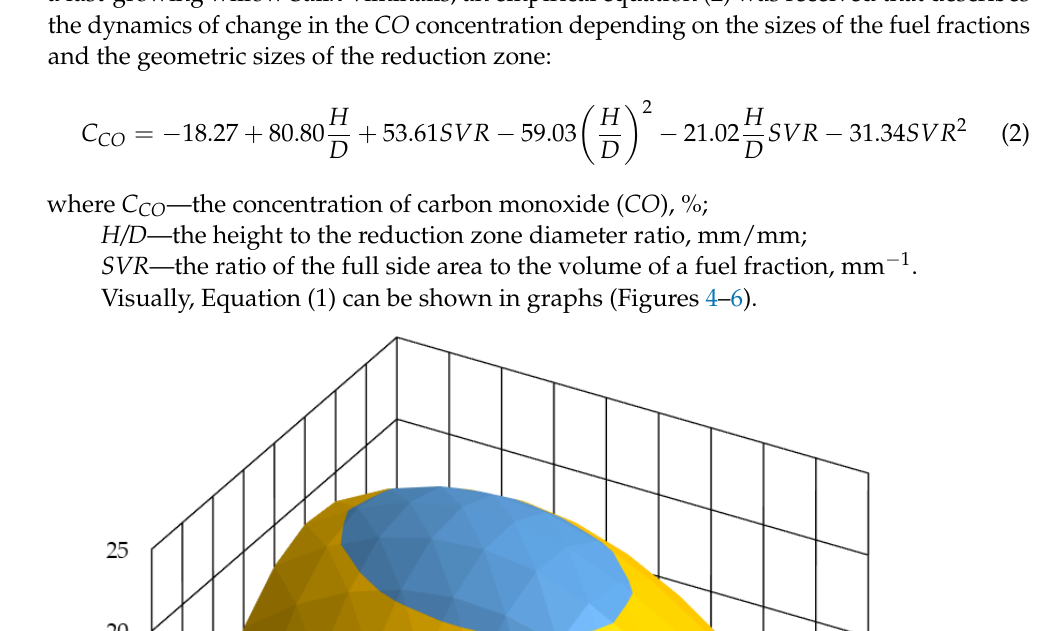
Figure 5. Graphic image of the dependence of CO concentration in the received gas on the ratio indicators of height to the reduction zone diameter ( H/D ). 7 9 11